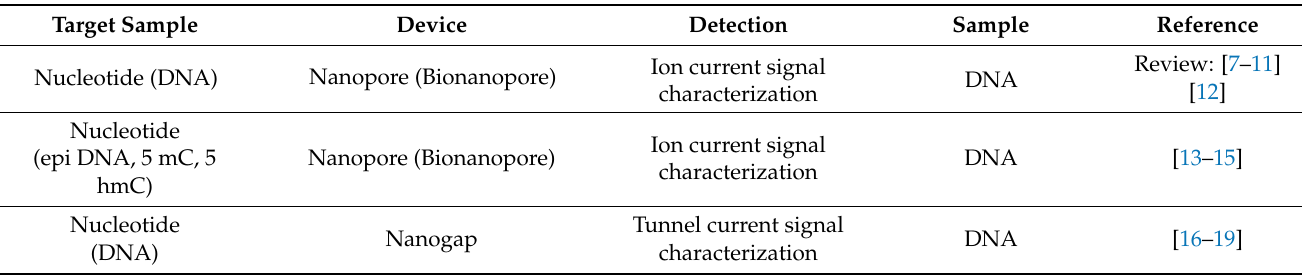
Table 1. Biomolecule-sensing species: device, target, and tools for single-molecule detection. Target